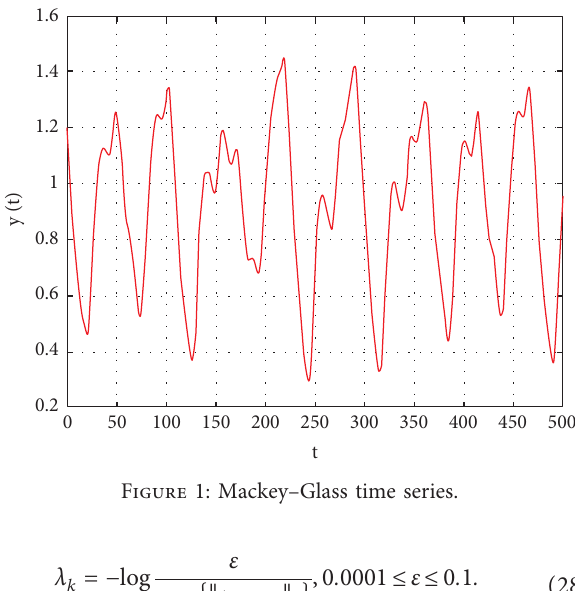
Figure 1: Mackey–Glass time